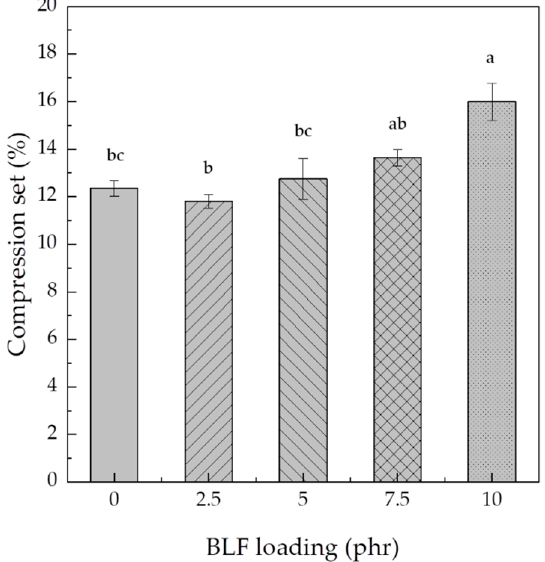
Figure 10. Compression set of NRL foam composite various BLF loading. Significant differences at p < 0.05 are shown by different letters. The values represent the mean ± S.E. of five replicates.